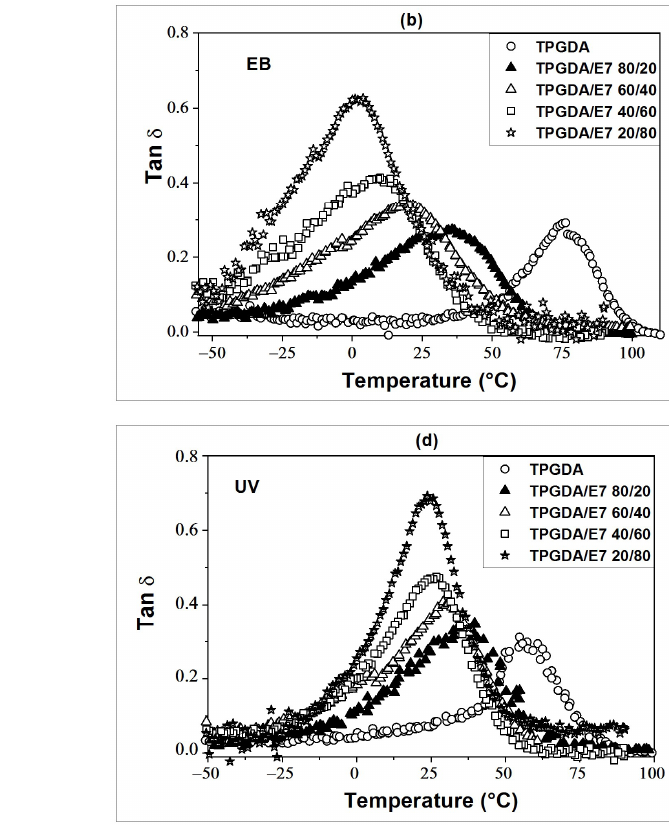
Figure 2. tan δ as function of temperature around T g (E7) ( a ) and ( c ) and T g poly (TPGDA) ( b ) and ( d ) at different LC concentrations for EB- and UV-cured films, respectively.